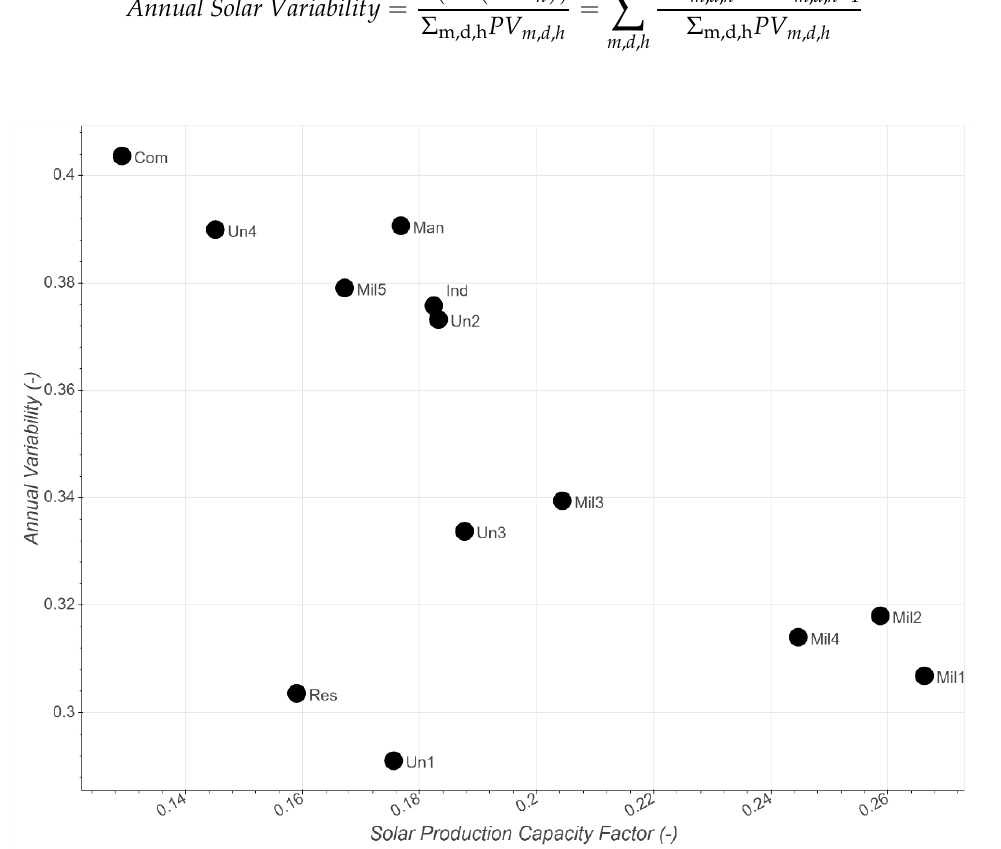
Figure 7. Solar production summary for all cases expressed through the annual capacity factor and the normalized annual solar